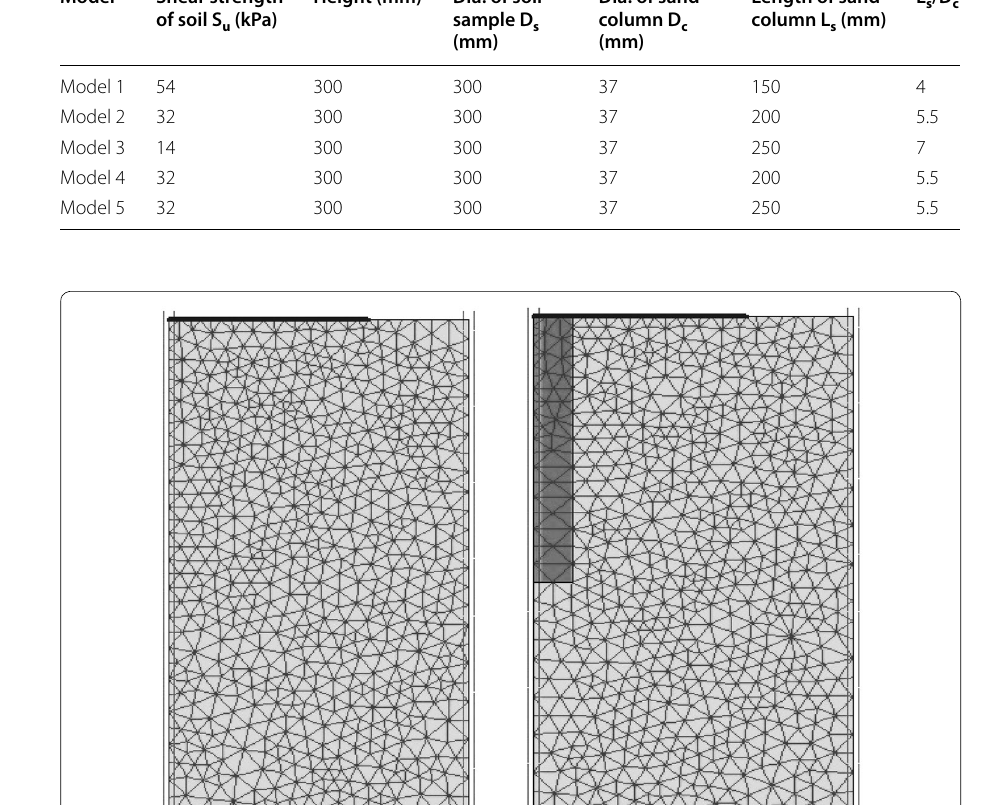
Table 4 Geometry data of different sand columns Model Shear strength Height (mm) Dia. of soil of soil S u (kPa) sample D s